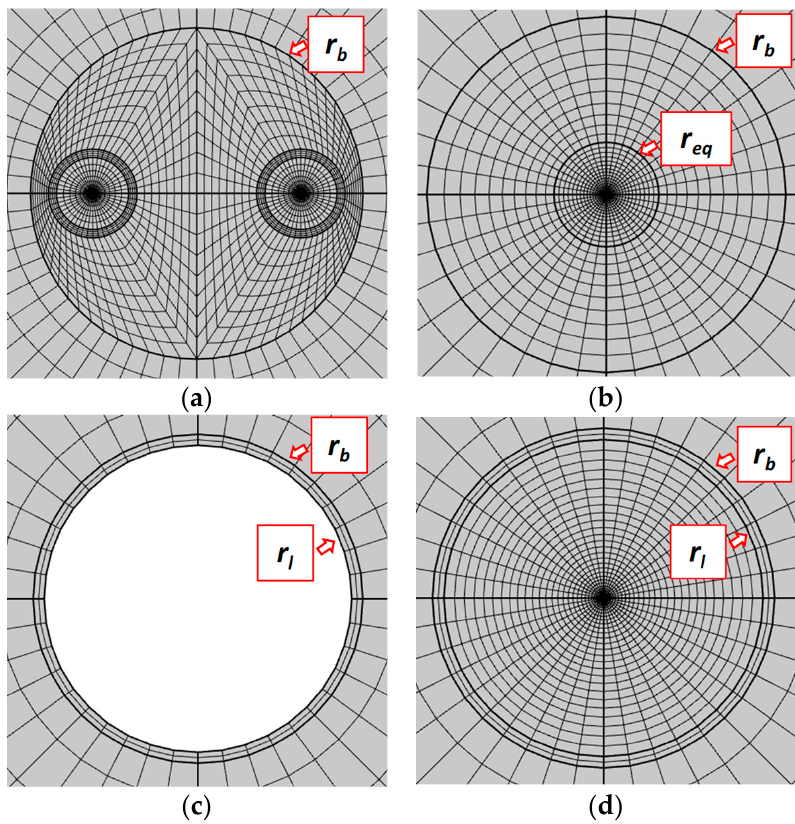
Figure 2. Particular of the mesh for the simulation of: ( a ) the real BHE cross section; ( b ) the OMEC cross section; ( c ) the FCS cross section; ( d ) the HCM cross section.